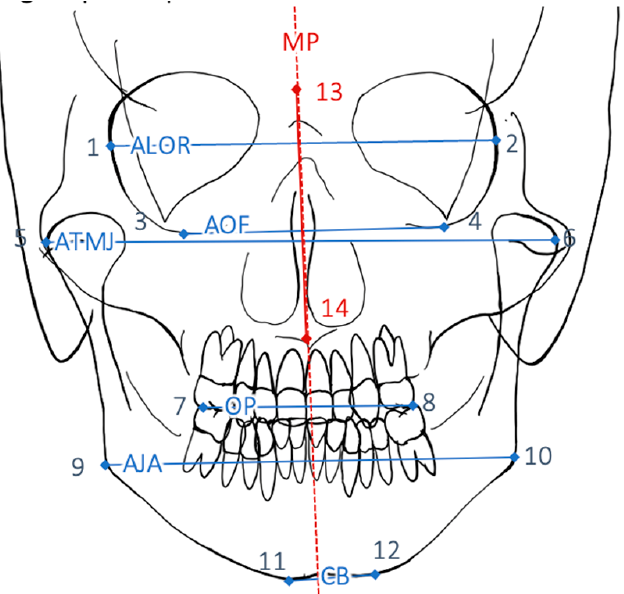
Figure 7. Radiological landmarks and axes as described in Table 3. Ideally the vertical (MP) should be perpendicular to all six axes axis of lateral orbital walls (ALOR), axis of orbital floors (AOF), axis of temporomandibular joints (ATMJ), occlusal plane (OP), axis of jaw angles (AJA), and chin base (CB). Table 3. Axes between two defined points (see Figure 1). Six angles between each axis and the mid- facial plane are determined.